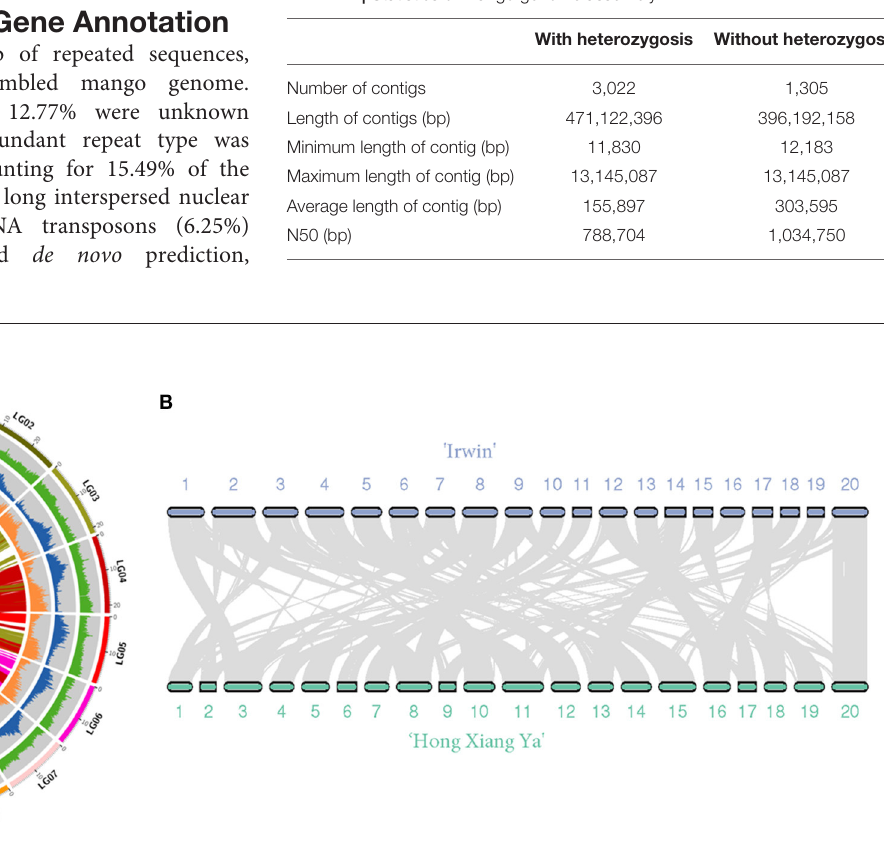
FIGURE 1 | (A) Overview of the “Irwin” genome. (a) pseudomolecules, (b) GC content (per 200kb), (c) repeat density (per 200kb), (d) gene density; (B) Synteny view of the “Irwin” and “Hong Xiang Ya” genomes.